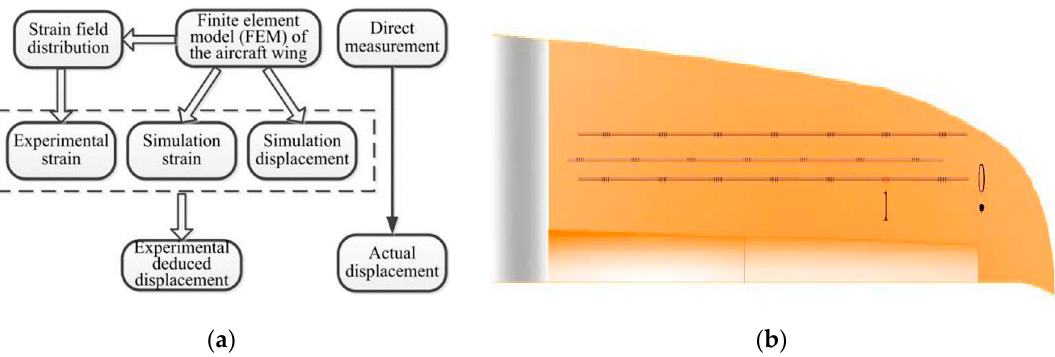
Figure 25. ( a ) Flow chart of deformation measurement; ( b ) Schematic diagram of location of experimental points [95].